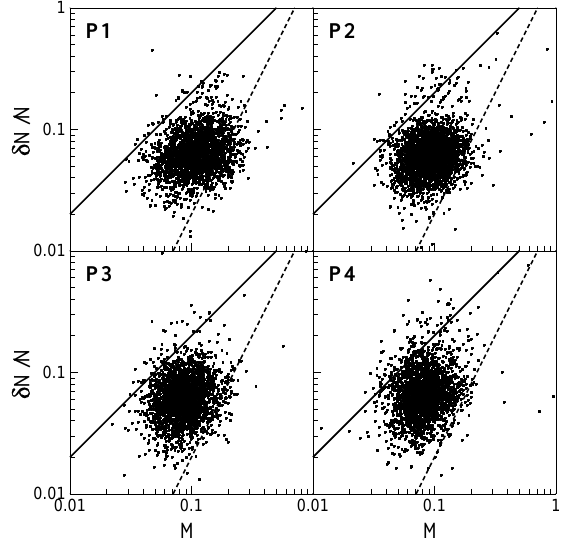
Fig. 13. Relative amplitude of density fluctuations versus turbulent Mach number for polar wind samples P1 to P4. Solid and dashed lines indicate the M and M 2 scalings,